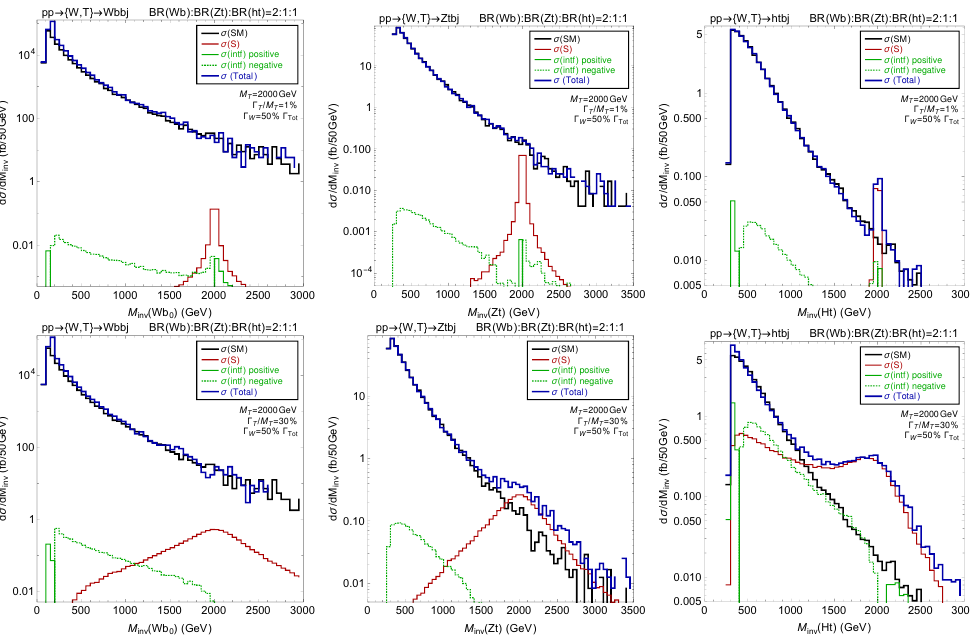
Figure 6 . Same as in figure 5 for M T = 2 TeV